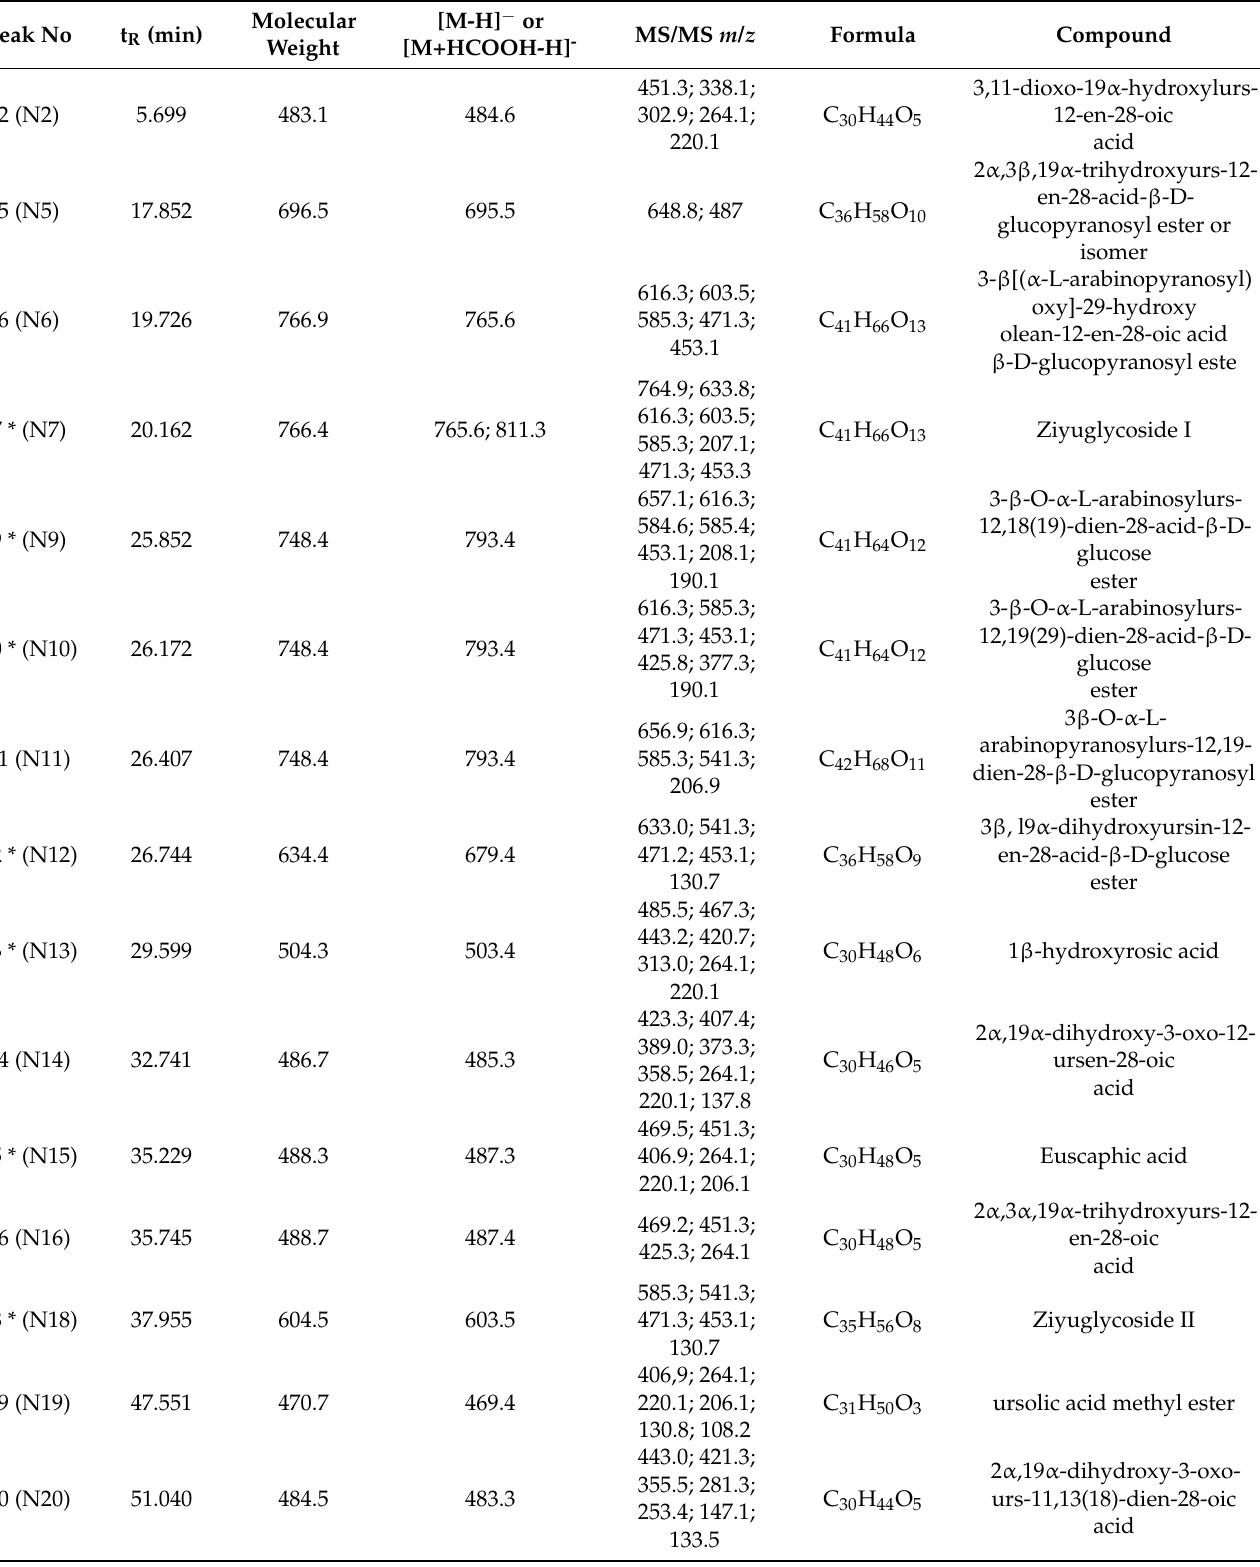
Table 1. Fragment ions of the common components in Sanguisorba officinalis L. before and after processing (UHPLC-ESI -